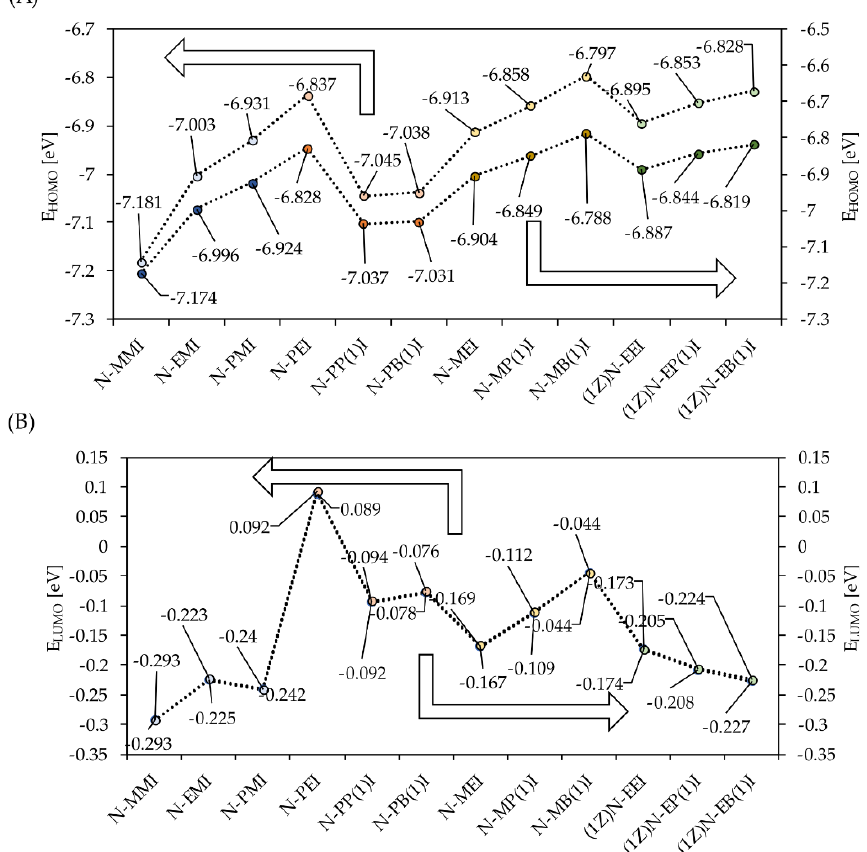
Figure 6 . E HOMO ( A ) and E LUMO ( B ) of investigated Schiff bases in HCl solution with concentrations of 1mol/dm 3 (blue line) and 2 mol/dm 3 (green line).